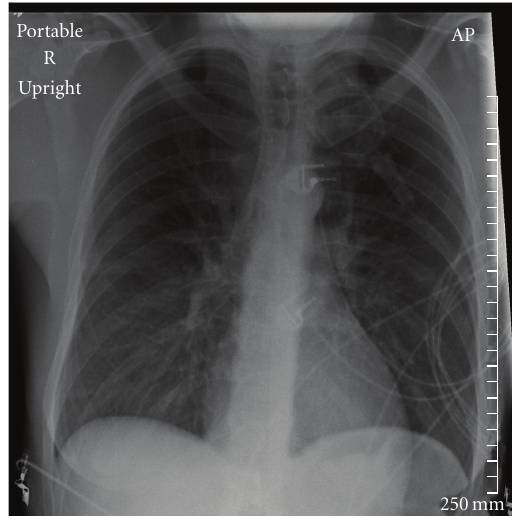
Figure 2: Case 2 chest X-ray at time 1944. Chest X-ray taken two hours after admission shows slight ground glass abnormalities despite significant improvement.